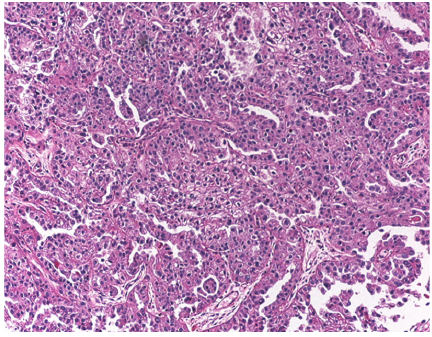
Figure 3: CK 20 negative axillary lymph node.